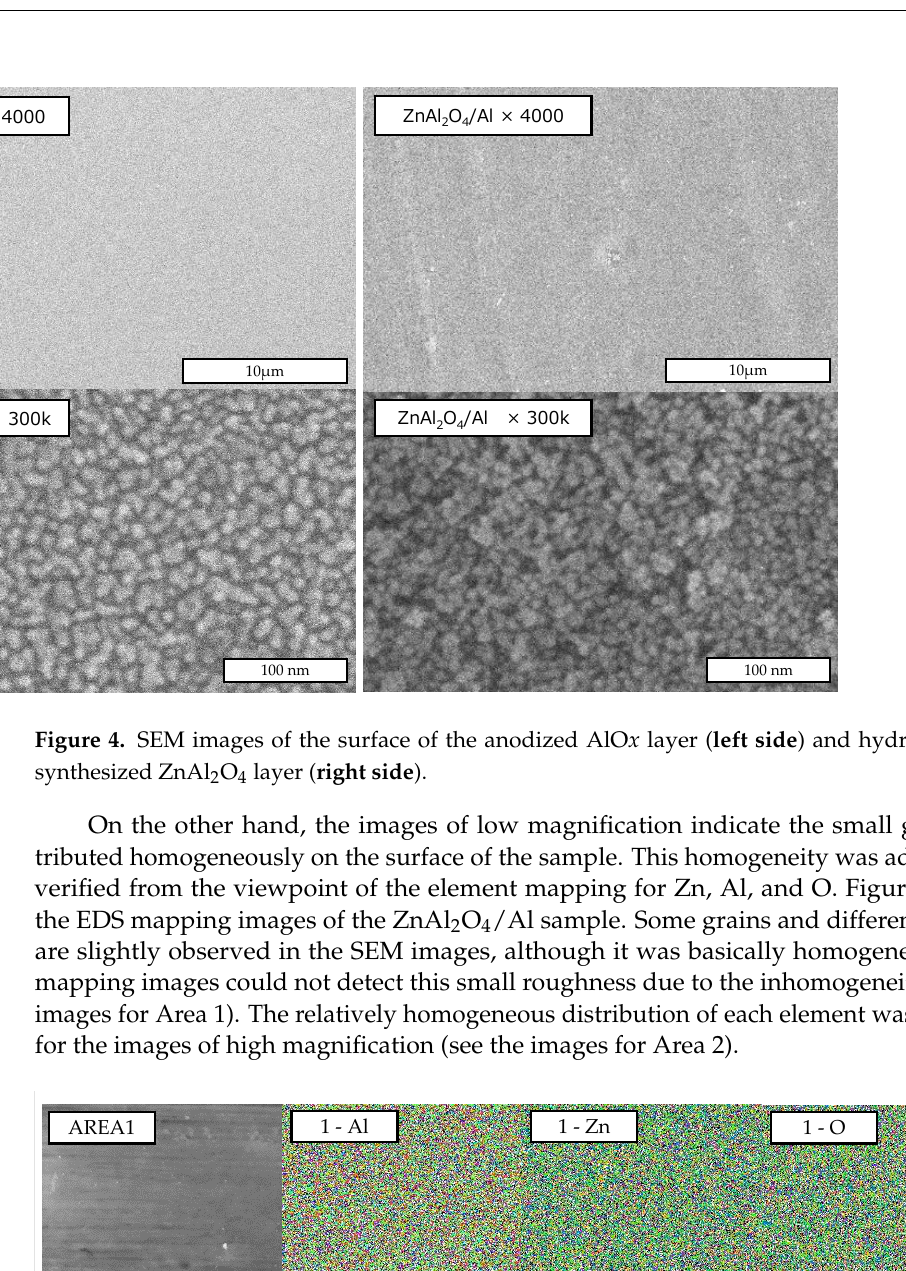
Figure 5. Mapping images observed by SEM-EDS for ZnAl 2 O 4 /Al sample. Area 1 shown on the top was 3000 times scale, and Area 2 (bottom) was 13,000 times, respectively.